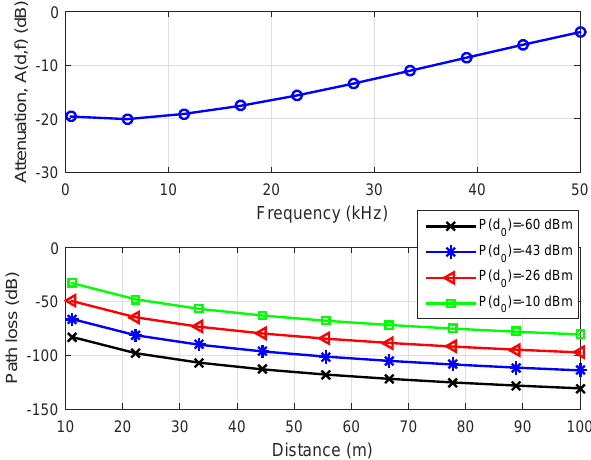
Figure 5. Attenuation coefficient A ( d , f ) versus frequency (top figure) and path loss versus distance (bottom